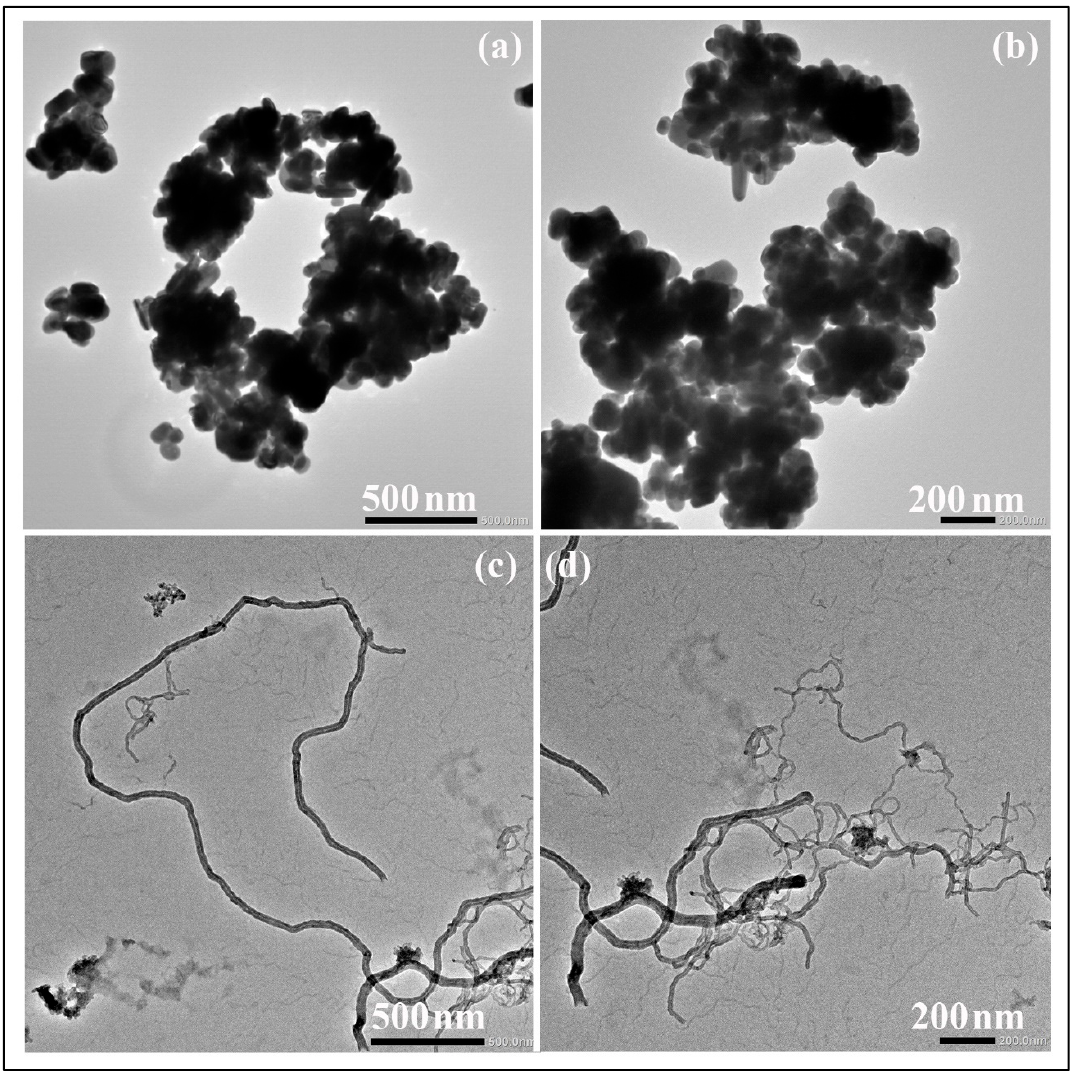
Figure 1. Transmission electron micrographs of silver nanoparticles ( a , b ) and carbon nanofibers ( c , d ) at two different magnifications. Table 1. Particle hydrodynamic sizes in nm of the two materials in water solution and in the Dulbecco’s modified Eagle medium (DMEM) used for biological characterization by the dynamic light scattering technique. The polydispersity index (PdI) values of the two materials are also given. DLS Material